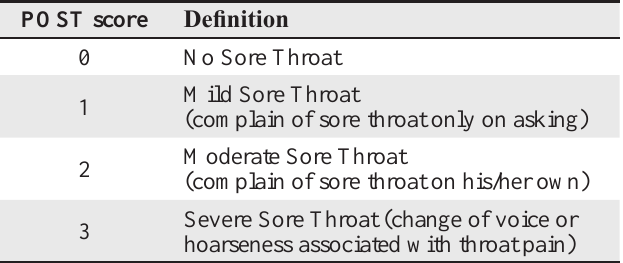
Table 1 . Postoperative Sore Throat (POST)